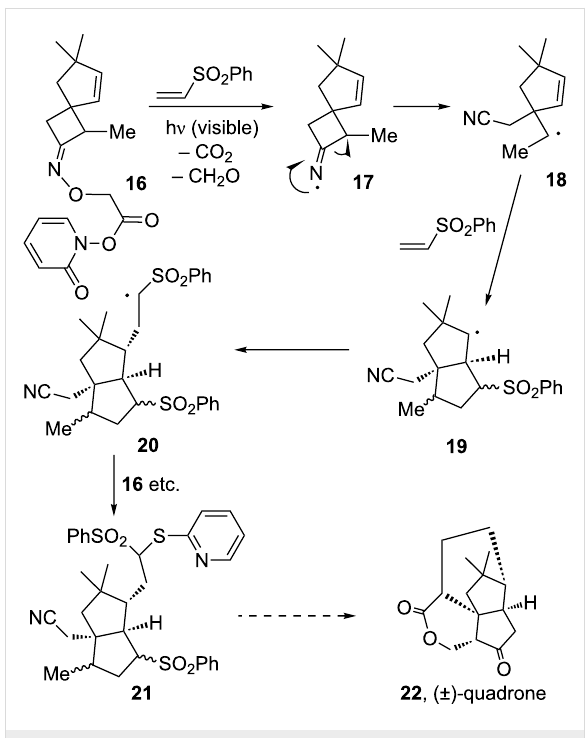
Scheme 4: Model radical sequence for the synthesis of